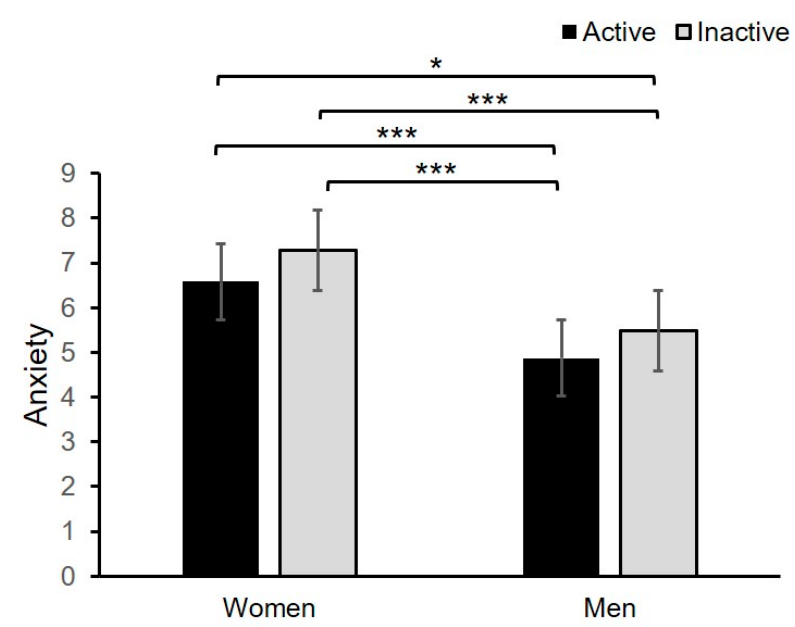
Figure 1. Mean anxiety scores for groups of undergraduates differing in sex (women, men) and engagement in physical activity (active, inactive). Error bars show standard errors. * p < 0.05, *** p < 0.001. A two-way ANOVA was conducted for depression as a dependent variable and sex (female, male) and PA groups (inactive, active) as independent variables (see Table 5 and Figure 2 for more